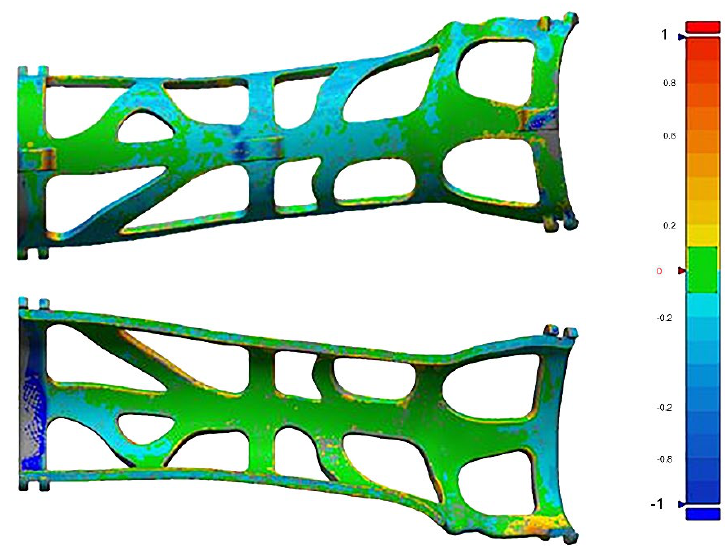
Figure 7. Mechanical integrity: comparison between the 3D scanning of an orthosis at the end of